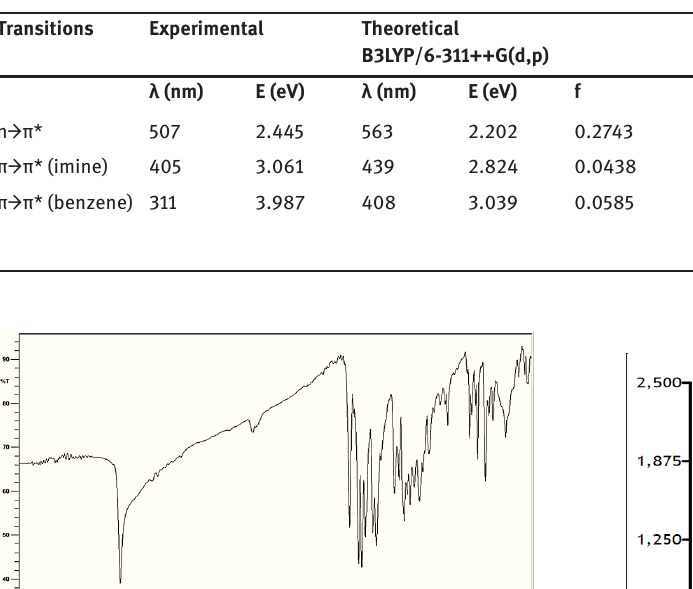
Table 2: The experimental and theoretical electronic transitions, excitation energies (eV), oscillator strengths (f) and major contributions of the PINQ molecule.